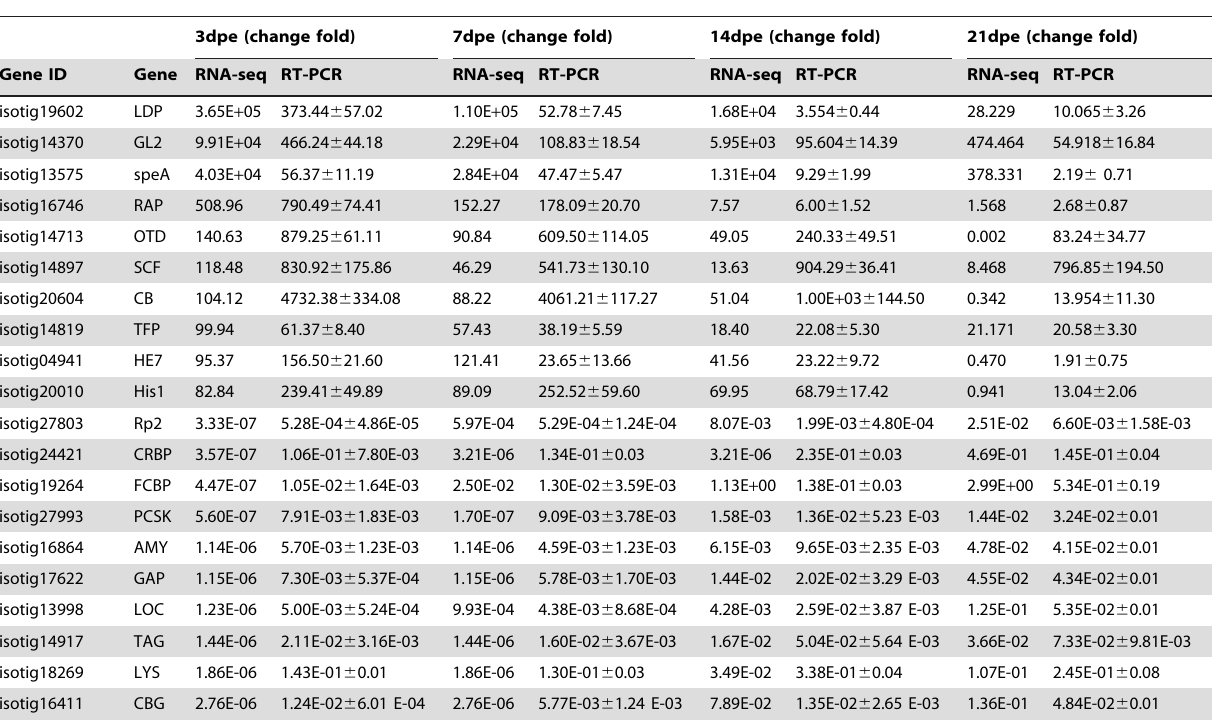
Table 7. Genes selected for Real-time PCR validation.